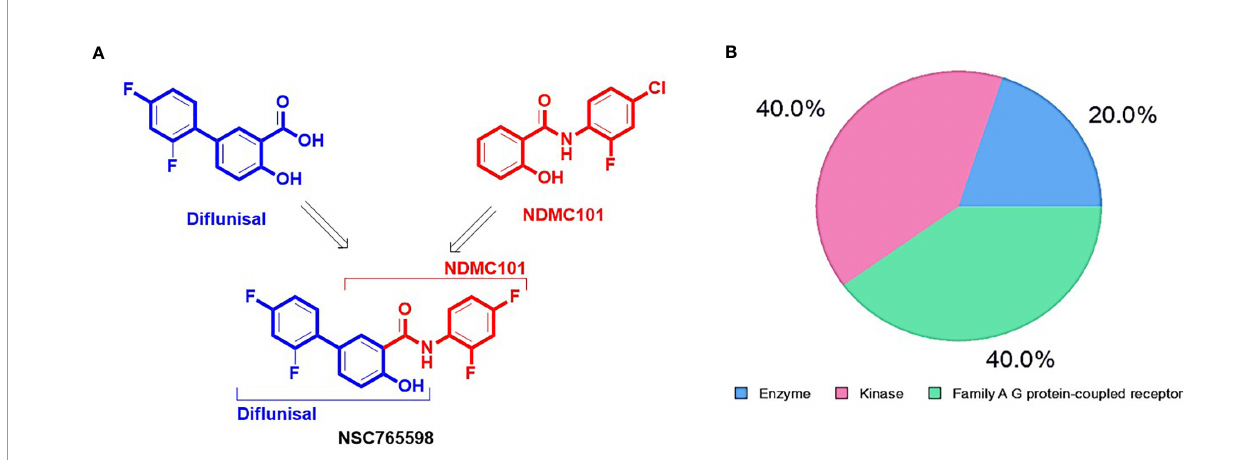
FIGURE 1 | Synthetic protocol and potential drug target classi fi cation of N-(2,4-di fl uorophenyl)-2 ’ ,4 ’ -di fl uoro-4-hydroxybiphenyl-3-carboxamide (NSC765598). (A) NSC765598 is a chemical derivative of di fl unisal and NDMC101s (reaction conditions; SOCl 2 , anhydrous THF, re fl ux, 8 h; and aniline, anhydrous THF, re fl ux 14-16) (B) . The SwissTarget identi fi ed top 20 targets of NSC765598 are classi fi ed into enzymes (20%), kinases (40%) and Family A G protein-coupled receptor